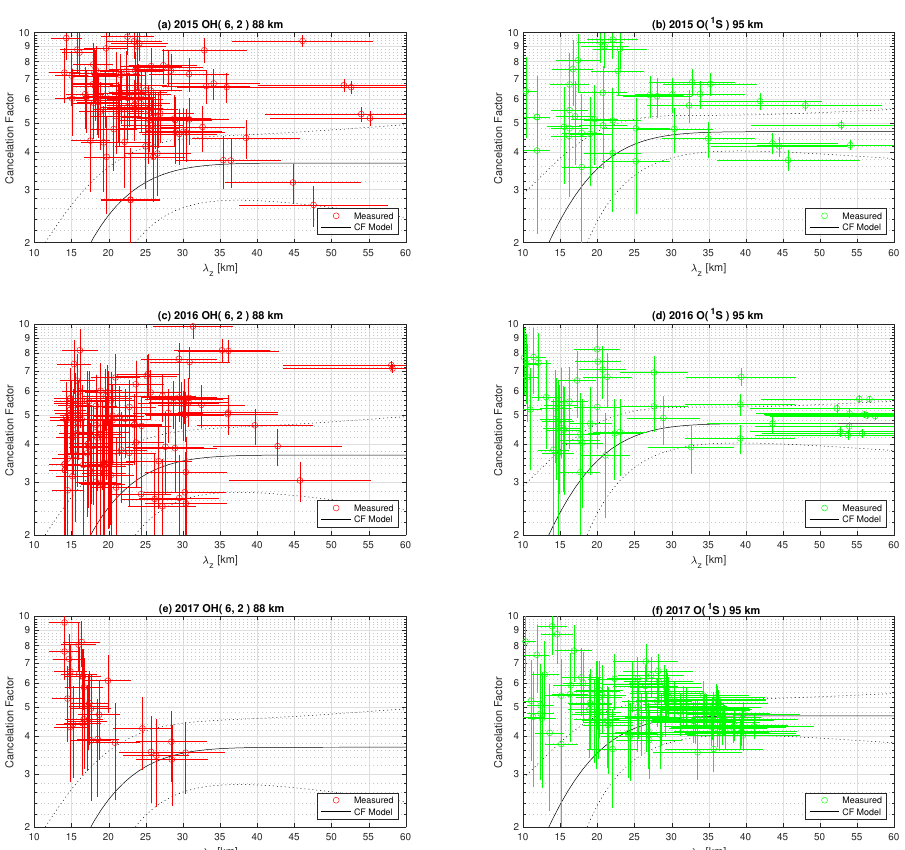
Figure 3. Observed CF for OH (red open circles) during ( a ) 2015, ( c ) 2016, and ( e ) 2017, and for O ( 1 S ) (green open circles) during during ( b ) 2015, ( d ) 2016, and ( f ) 2017. The horizontal ( σ λ ( σ CF ) errors are also shown. The dotted thin lines denote the 95% confidence bounds (2 σ ) around the analytic curves shown as the continuous black lines in the